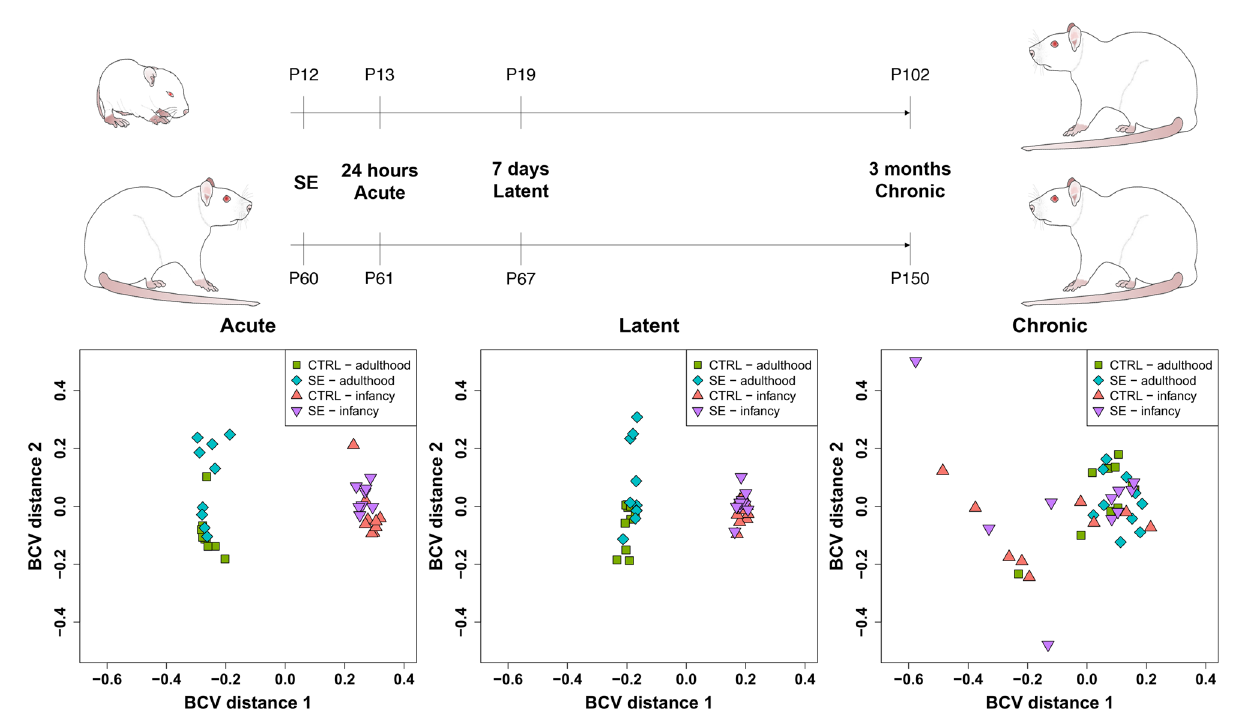
Figure 1. Timelines and Multidimensional Scaling (MDS) of complete miRNA expression. Timelines depict the age of animals (as a number of postnatal days P) at the status epilepticus (SE) induction and tissue collection separately for individual onset ages (infancy and adulthood). Tissue collection timepoints (24 h, 7 days, and 3 months) correspond with epileptogenesis stages: acute, latent, and chronic. The MDS plot is a clustering method to compute the relative variability of expression among samples and visualize the level of their similarity. The MDS plots were constructed using miRNA expression data (normalized read count from sequencing) and used “Biological coefficient of variation” (BCV) to compute distances. Points represent samples of the adult- onset (blue) and infantile-onset (violet) onset of epilepsy and their controls (adult—green, infantile—red). Individual plots depict clustering in a specific stage of